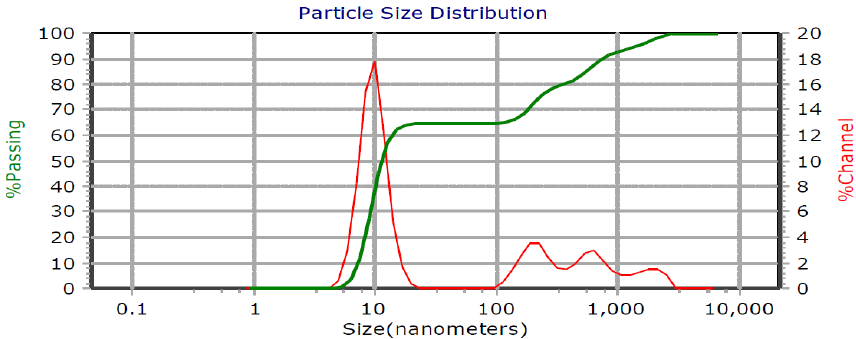
Figure 1. PSA spectrum of T1 NFs.